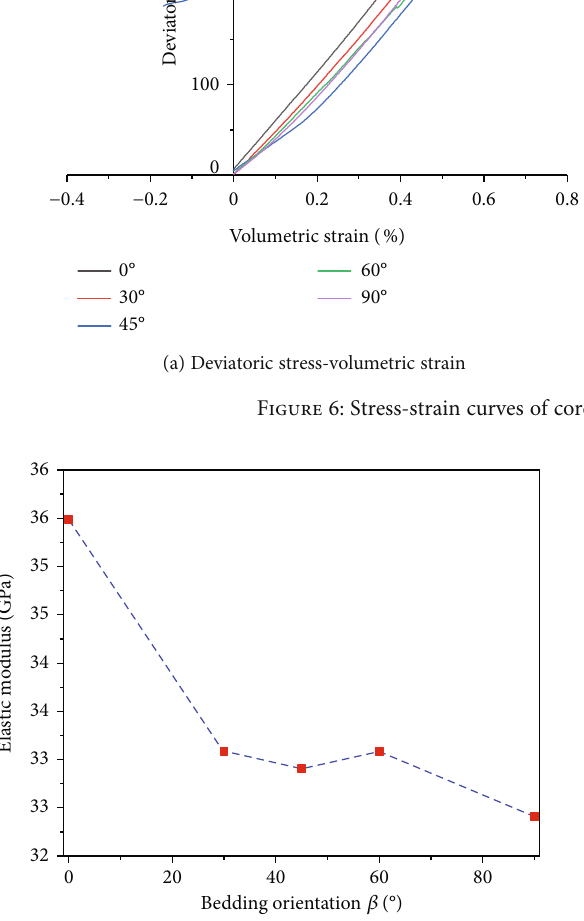
Figure 7: Variation of elastic modulus over β :